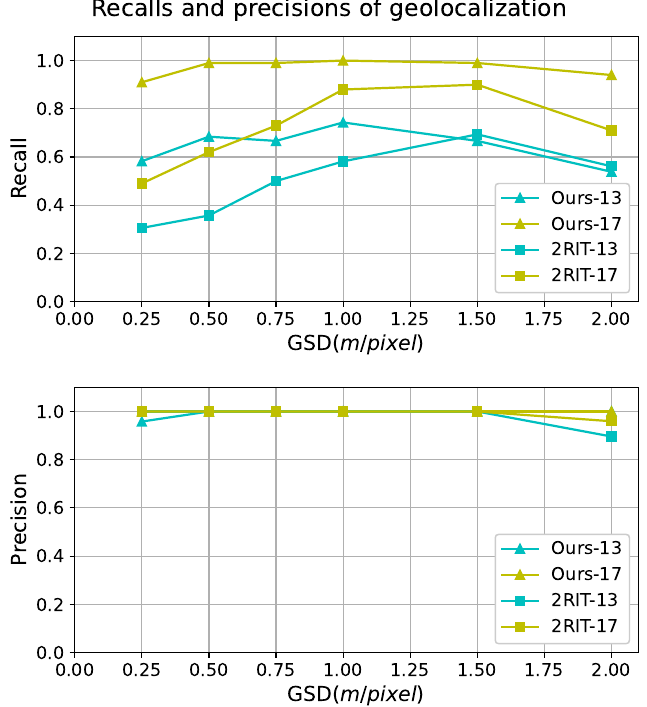
Figure 9. Precision and recall of geolocalization under different GSDs of the “2RIT” method [5] and our